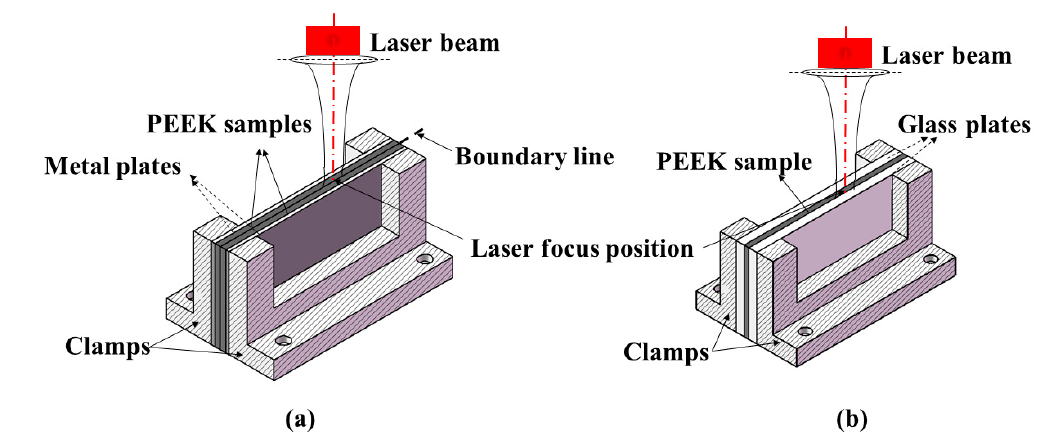
Figure 2. Schematic diagram for sample clamping device with sandwich structure: ( a ) two identical PEEK samples pressed together by two metal plates; ( b ) one PEEK sample sandwiched between two glass plates.